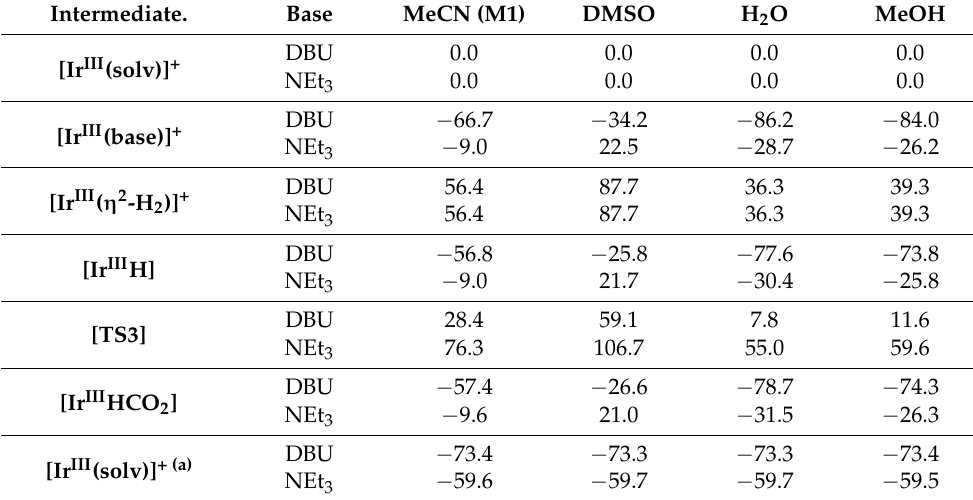
Table 2. Calculated relative enthalpies (DFT, B3LYP-D3/def2-SVP level of theory in kJ mol − 1 ) for the catalytic cycle of monometallic Ir complexes for different solvents and bases. Intermediate. Base MeCN (M1) DMSO H 2